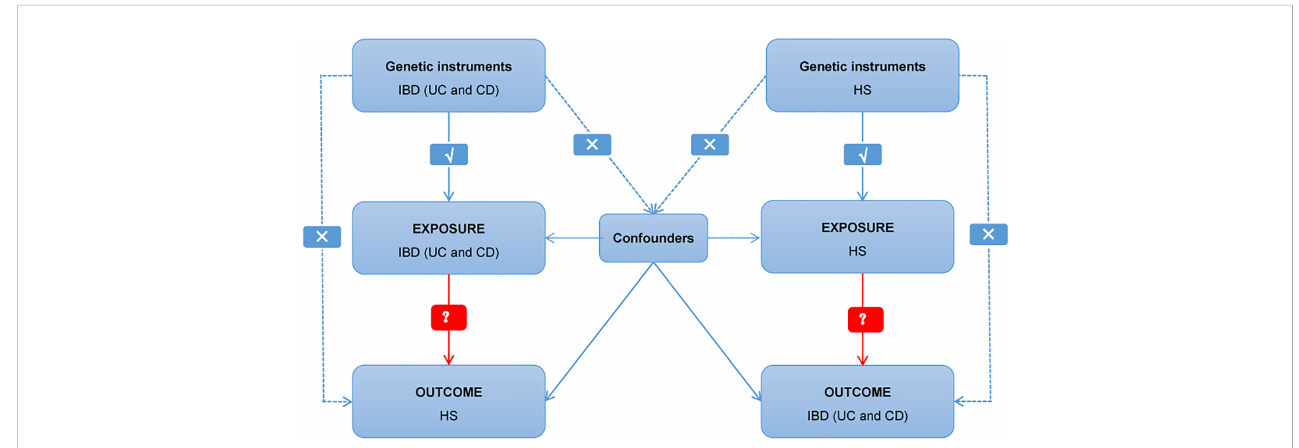
FIGURE 1 Diagram of critical assumptions for MR analysis. The solid line indicates that genetic instruments (SNPs) are related to exposure and can only affect the results through exposure. The dashed line indicates genetic instruments (SNPs) independent of any confounding variables between the results. IBD, in fl ammatory bowel disease; UC, ulcerative colitis; CD, Crohn ’ s disease; HS, hidradenitis